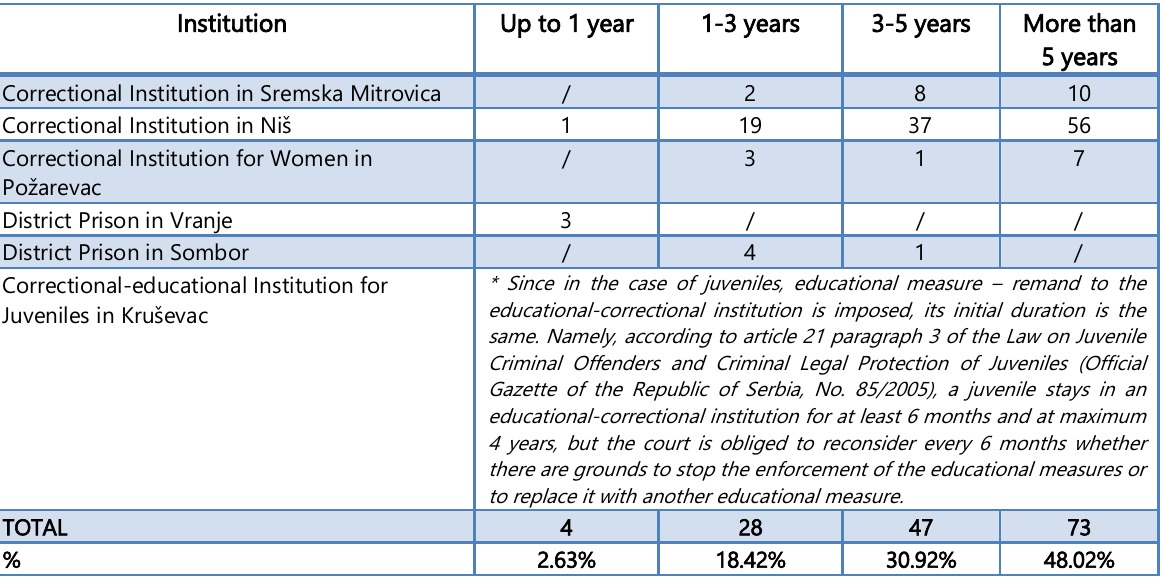
Table 4: Imposed Sanction (Source: Author‟s